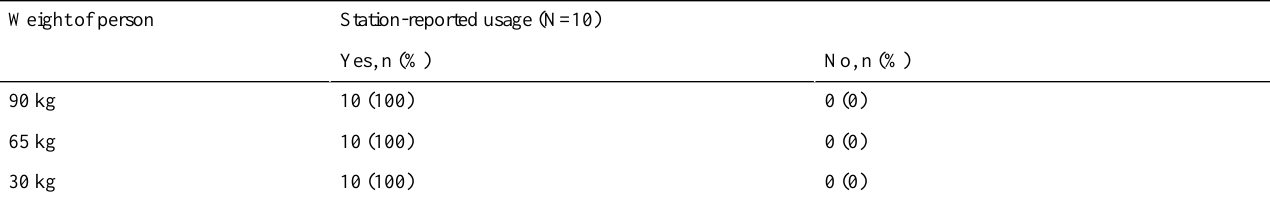
Table 1. Agreement between observed handwashing usage and station-recorded measurements.